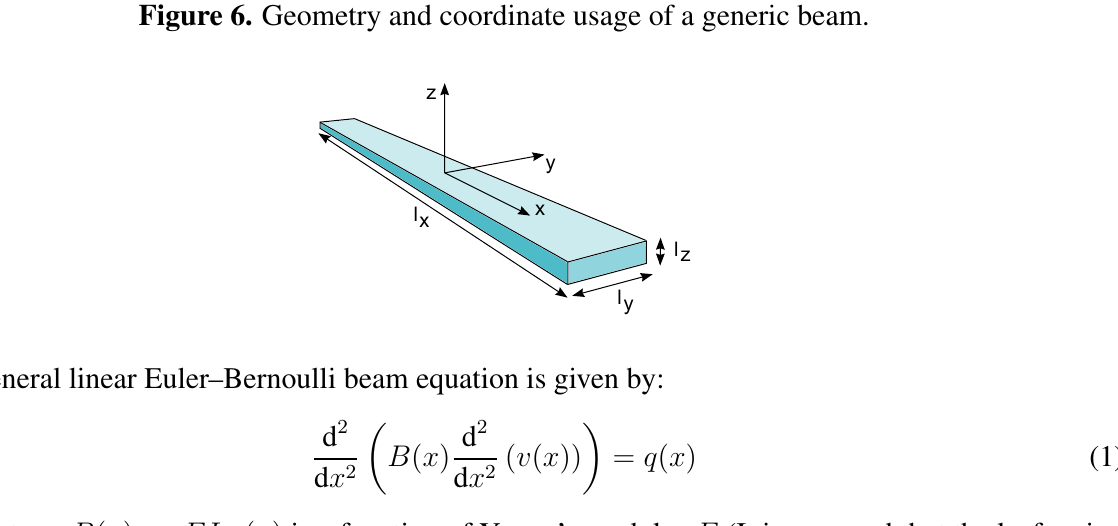
Figure 6. Geometry and coordinate usage of a generic